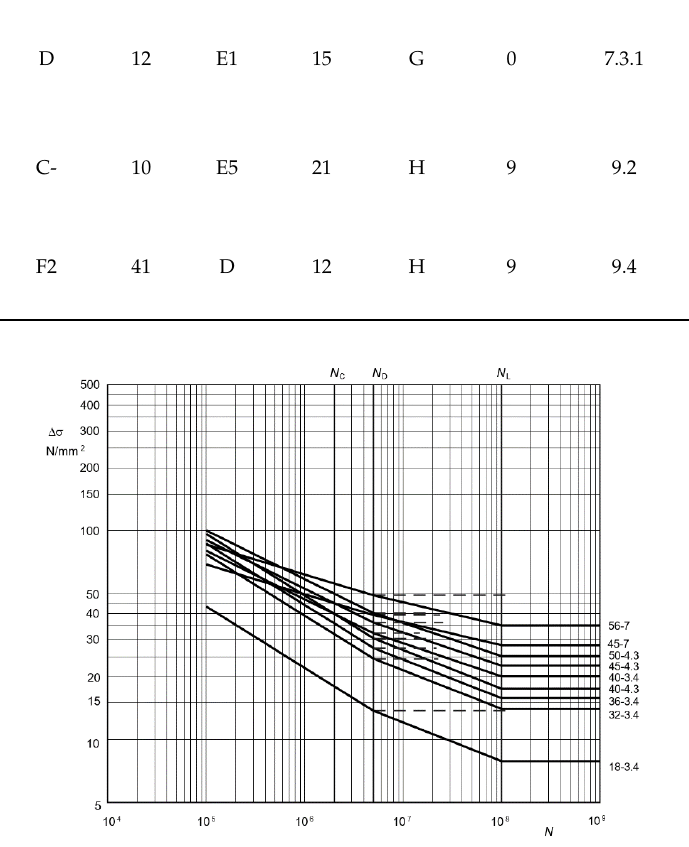
Figure 5. S-N curves for butt-welded joint [23].